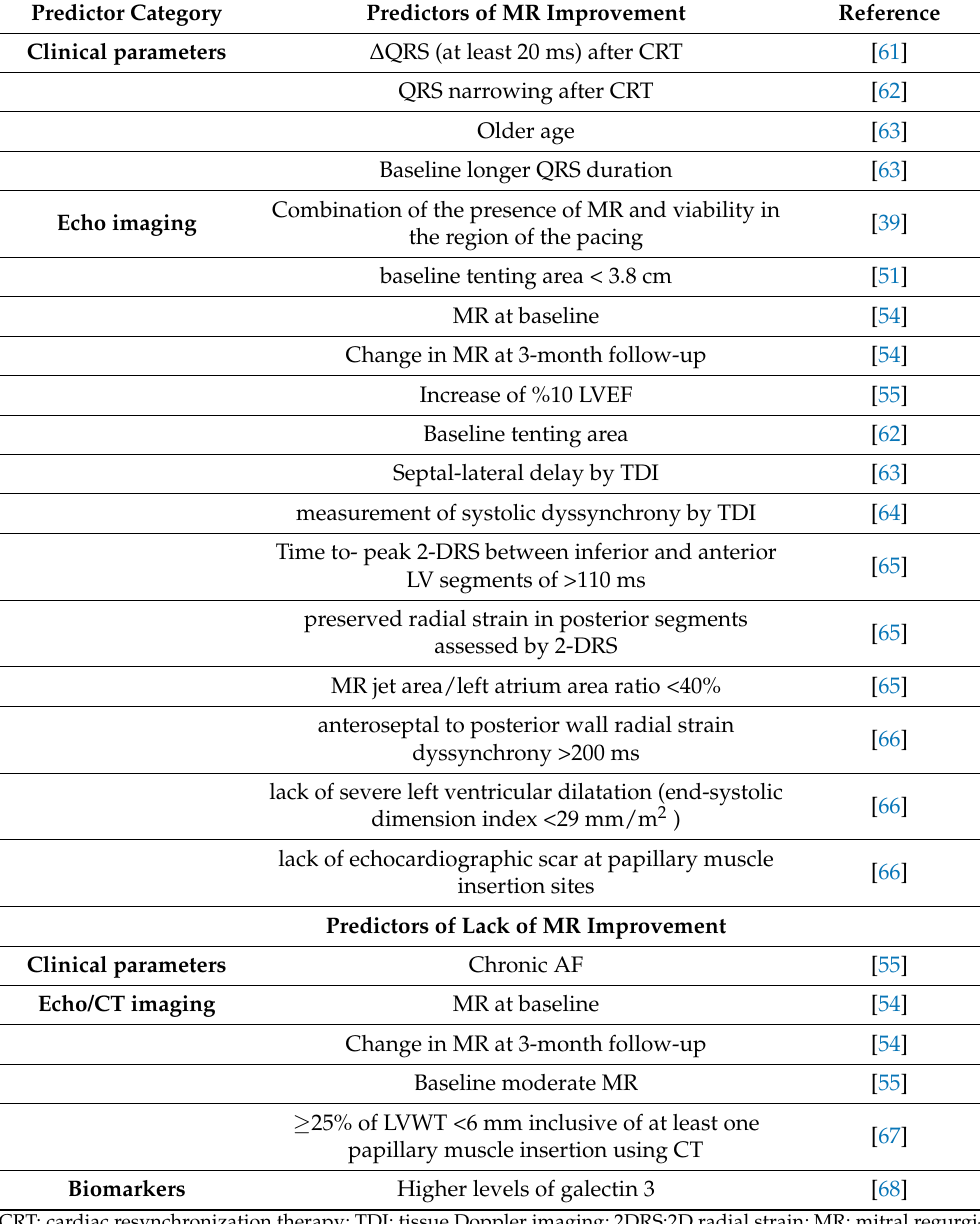
Table 2. Variables that Aid in Predicting and Monitoring MR